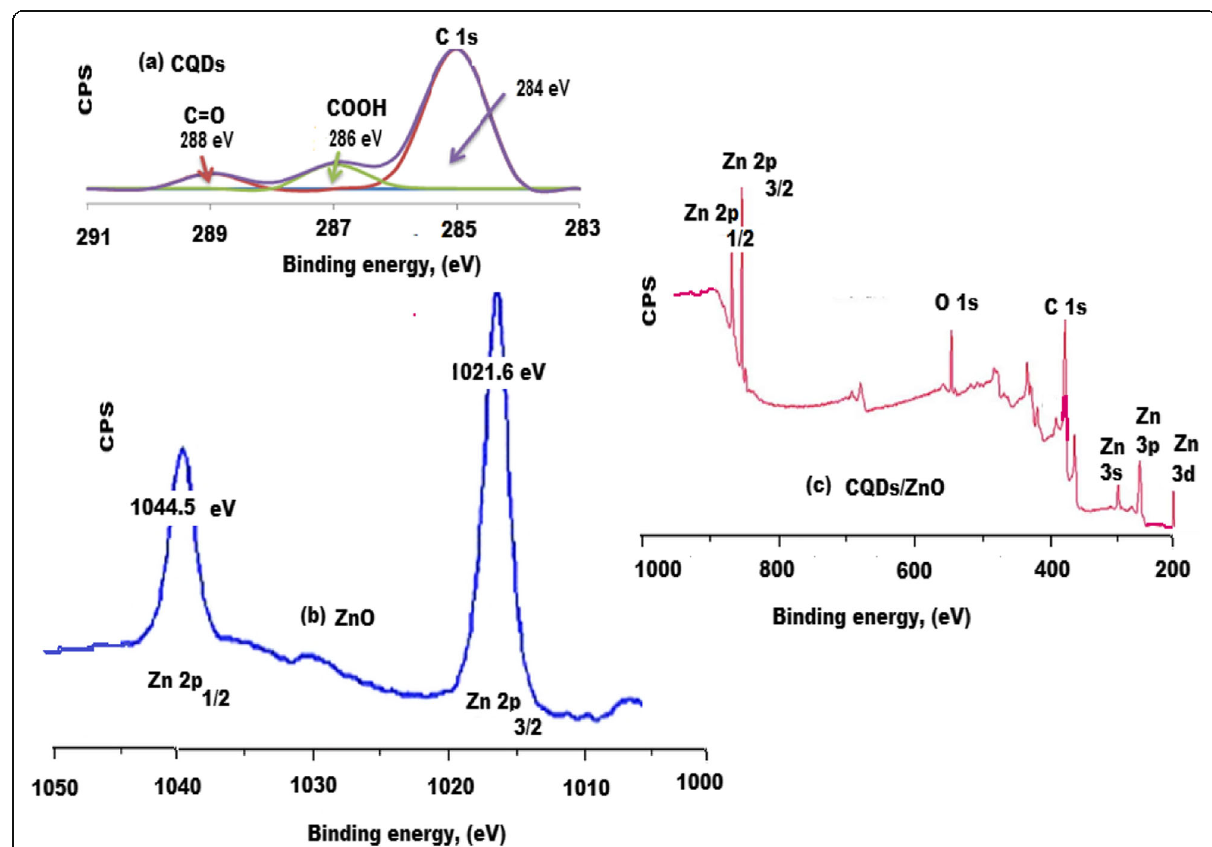
Fig. 6 X-ray photoelectron spectroscopy (XPS) spectra of a CQDs, b ZnO, and c CQDs/ZnO nanocomposite